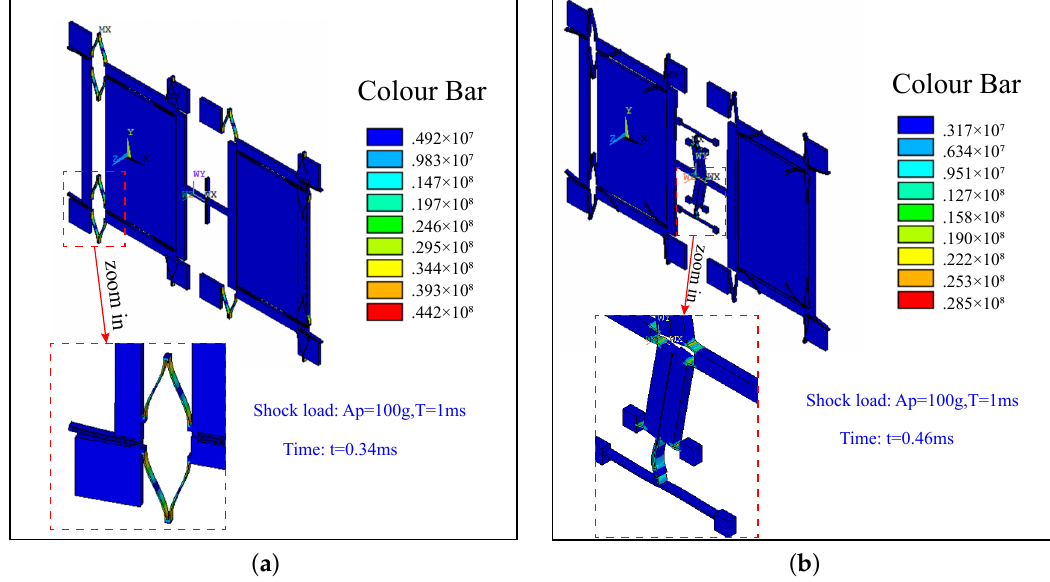
Figure 17. The stress distributions of Type-A ( a ) and Type-B ( b ) at the maximum impact